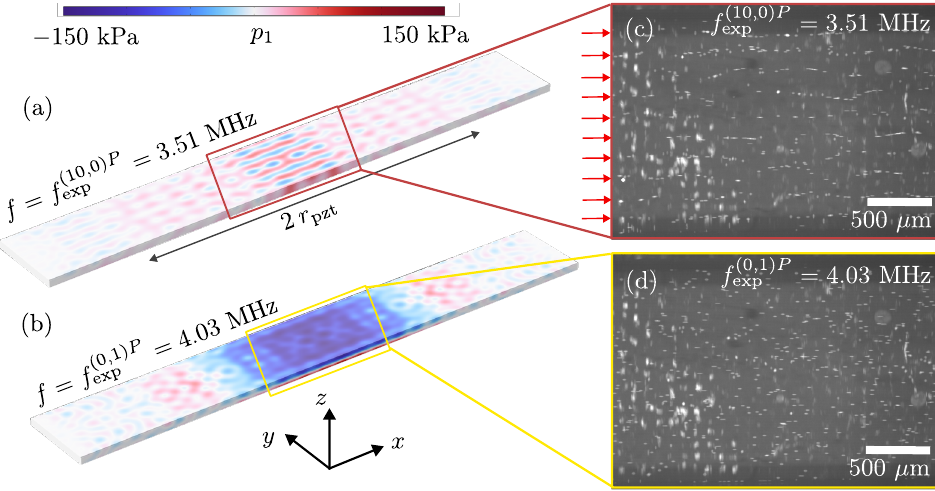
Figure 5. Color plot from − 150 kPa (blue) to 150 kPa (red) of the simulated acoustic pressure ( 10,0 ) P = 3.51 MHz with a standing-5-wavelength field p 1 inside the fluid channel at ( a ) f = f exp resonance mode in the y -direction (10 nodal lines above the center region of the transducer), and ( b ) at ( 0,1 ) P = 4.03 MHz with a standing- 1 f = f -wavelength resonance mode in z -direction. ( c ) Micrograph exp 2 of the particles focused in 10 nodal lines (marked by red arrows) inside the microfluidic channel ( 10,0 ) P = 3.51 MHz. ( d ) Micrograph of the particles focused after 4 s at the resonance frequency f exp in 1 nodal plane (the xy -plane) inside the microfluidic channel after 4 s at the resonance frequency ( 0,1 ) P = 4.03 f exp